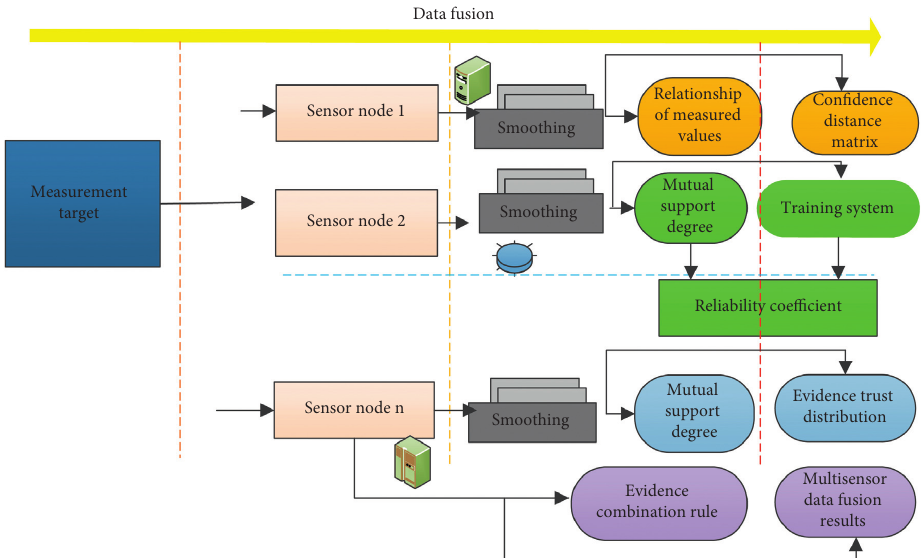
Figure 1: Data fusion model based on fuzzy